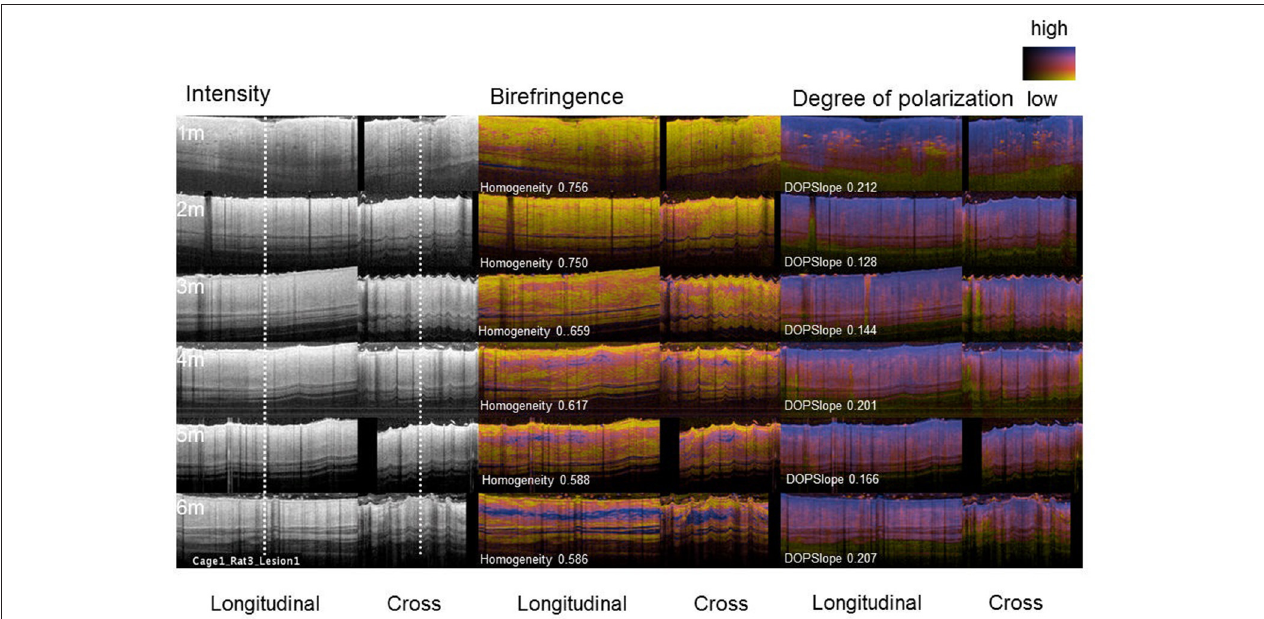
FIGURE 2 | PS-OFDI images of a developing scar following third degree burn injury in the dorsal skin of a rat. Longitudinal and cross-sectional views of the healing burn wounds at several time points in the same animal ( n = 36 wounds, 9 animals, 2–3 volumes acquired from each wound).